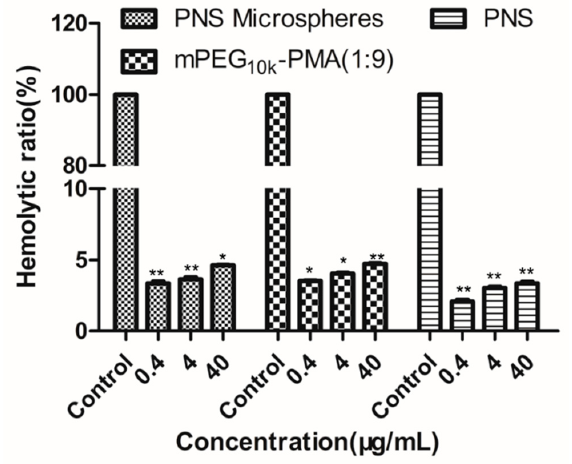
Figure 6. Haemolysis test results of PNS-loaded mPEG 10k -PMA (1:9) microspheres. * P < 0.05 and ** P < 0.01, compared with control and the whole blood sample with the PNS was used as a control.